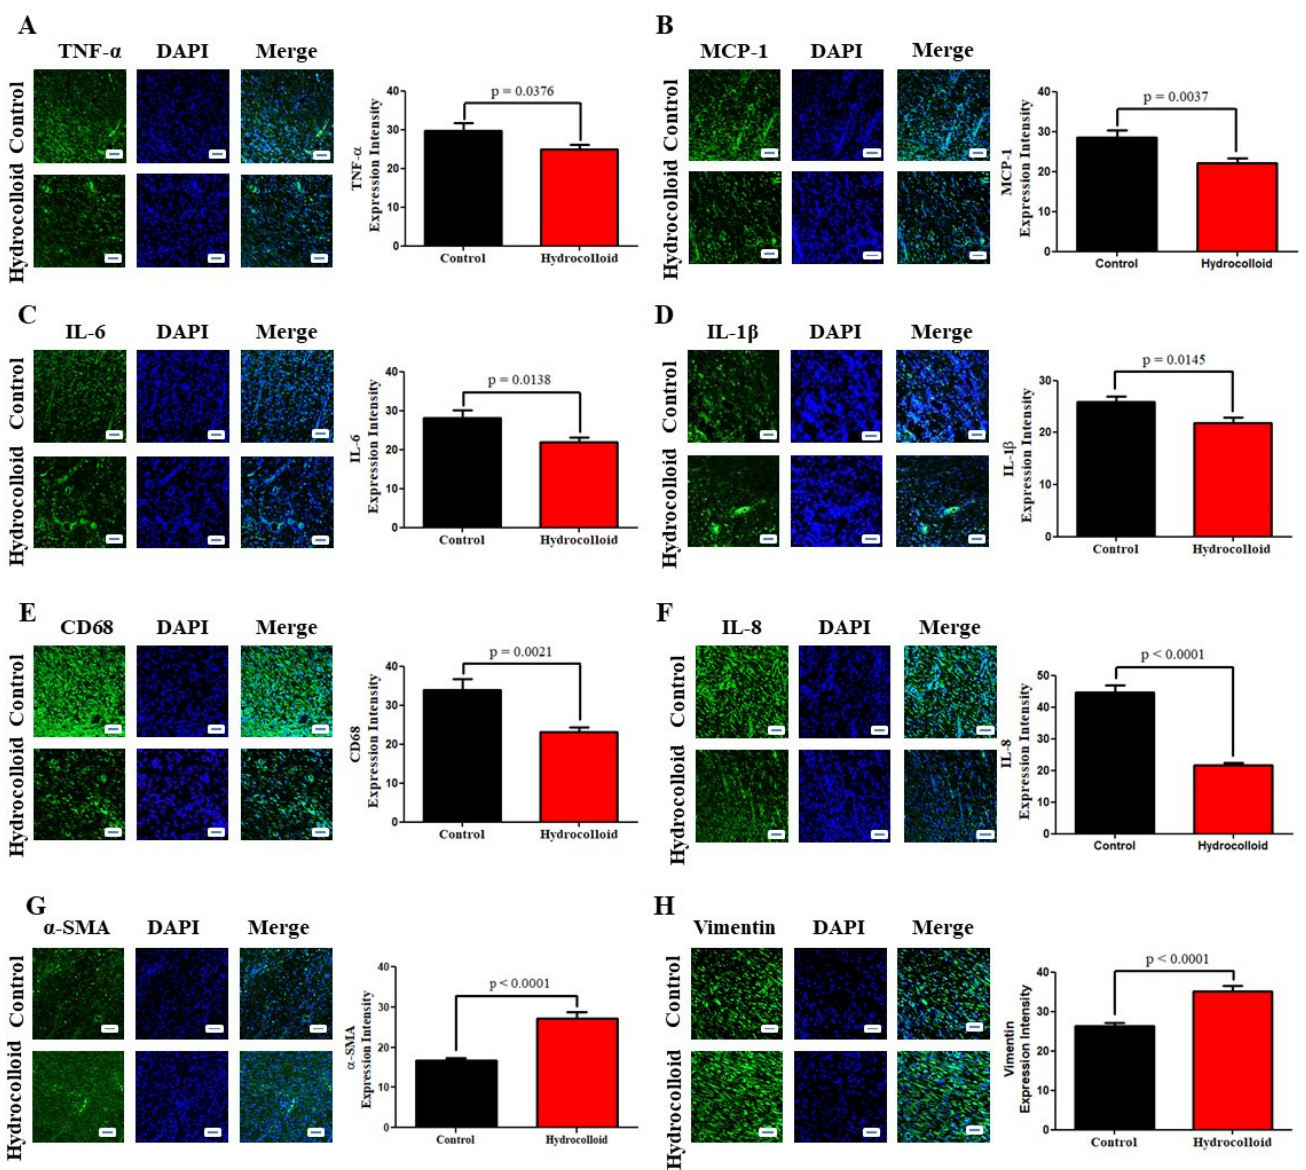
Figure 3. A hydrocolloid patch covered with ZnO nanoparticles bolsters inflammation and proliferative phases, which is confirmed by immunofluorescence staining. Fluorescent micrographs showing different cytokine staining of tissues growing on the posterior wound after 10 days and the quantitative density gap of the inflammation response of the two groups on day 10. ( A ) Tumor necrosis factor-alpha, TNF- α . ( B ) Interleukin 8, IL-8. ( C ) Interleukin 6, IL-6. ( D ) Interleukin 1 beta, IL-1 β . ( E ) Cluster of Differentiation 68, CD68. ( F ) Monocyte chemoattractant protein-1, MCP-1. The quantitative density gap of proliferative response of the two groups on day 10. ( G ) Alpha smooth muscle actin, α -SMA. ( H ) Vimentin. Scale bars are 50 µ m. LPS is a well-known pro-inflammatory agent in cell culture that is naturally produced by gram-negative bacteria. Figure 4 depicts the release of inflammatory mediators. The release of IL-6 and TNF- α was significantly affected by LPS treatment in different cell culture conditions ( p = 0.05). Figure 4A shows the concentrations of IL-6 in cell fluids after 24 h of incubation. While the positive control (LPS) has the highest concentration of IL-6 (11.2 ± 1.1), the other two groups have IL-6 concentrations similar to that of the control group (5.9 ± 1.0) (HC + LPS: 6.6 ± 0.5 and HC: 6.4 ± 0.9). This demonstrates that HC could destroy substances that cause